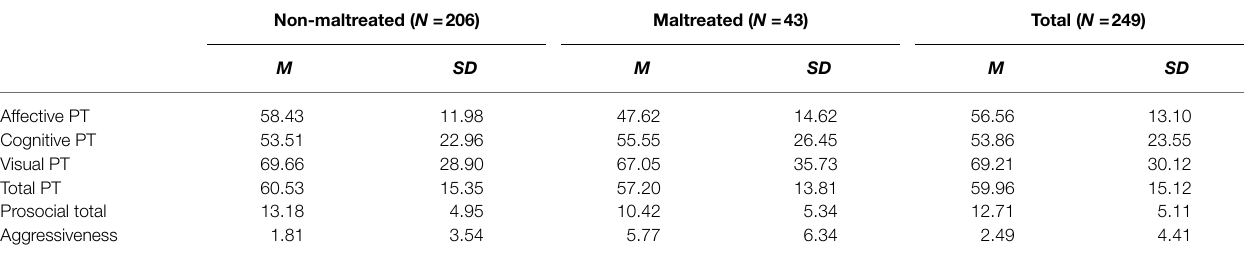
TABLE 2 | Perspective taking, prosocial, and aggressive behaviors for the presence of maltreatment: descriptive statistics. Non-maltreated ( N = 206)